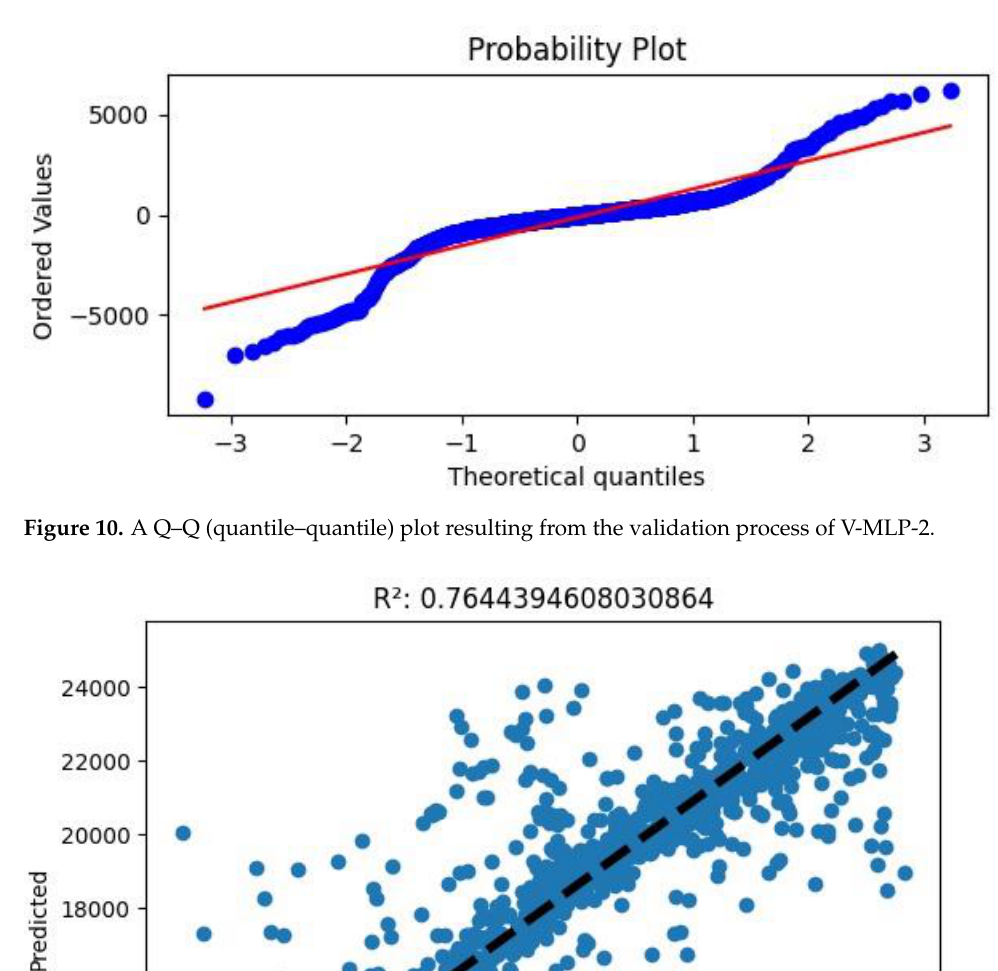
Figure 9. Histogram of residuals showing the probability density distribution of residuals resulting from the validation process of V-MLP-2.